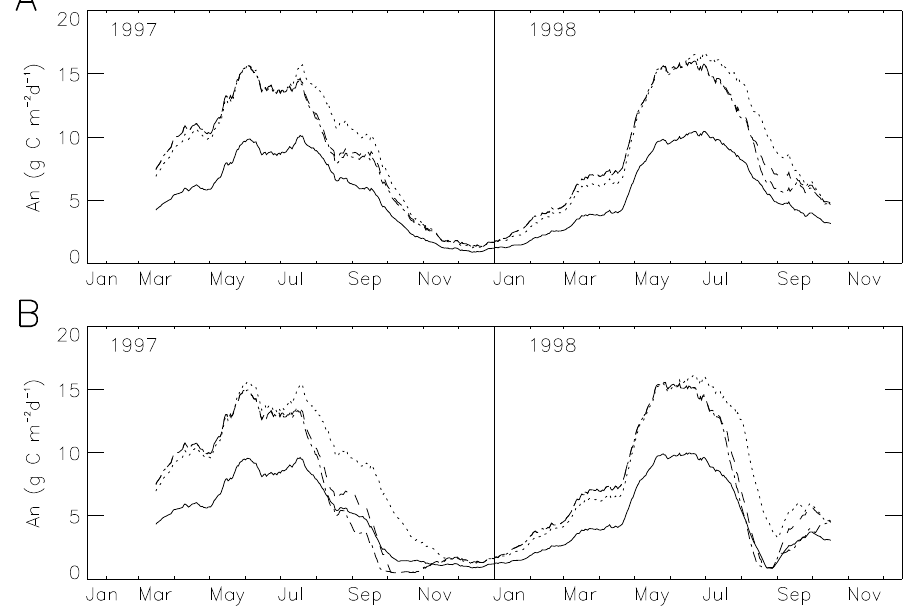
Fig. 6. Modelled leaf-net assimilation ( A n ) of Le-Bray, for different climate scenarios, 350, 700, 700+ and 700+pp (solid, dotted, dashed, and dash-dotted lines, respectively). The ISBA-A-g s model was run using the Picon drought-avoiding parameterisation (gm*=1.58mms − 1 , f0*=0.6, D max =100gkg − 1 , θ c =0.01), considering (A) a single layer of maritime pine, or (B) a layer of maritime pine and an additional layer representing the purple moor-grass undergrowth. The A n values are smoothed using a 30-day moving average, in order to show the general